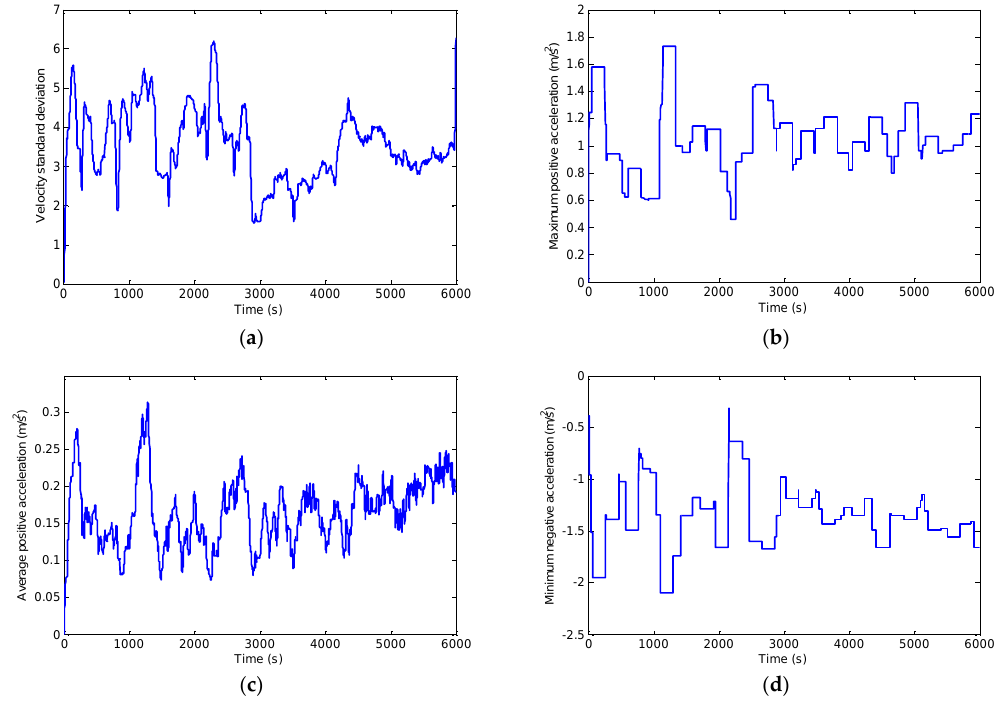
Figure 17. Characteristic parameters extracted from congested urban driving cycle. ( a ) Velocity standard deviation; ( b ) Maximum positive acceleration; ( c ) Average positive acceleration; ( d ) Minimum negative acceleration.